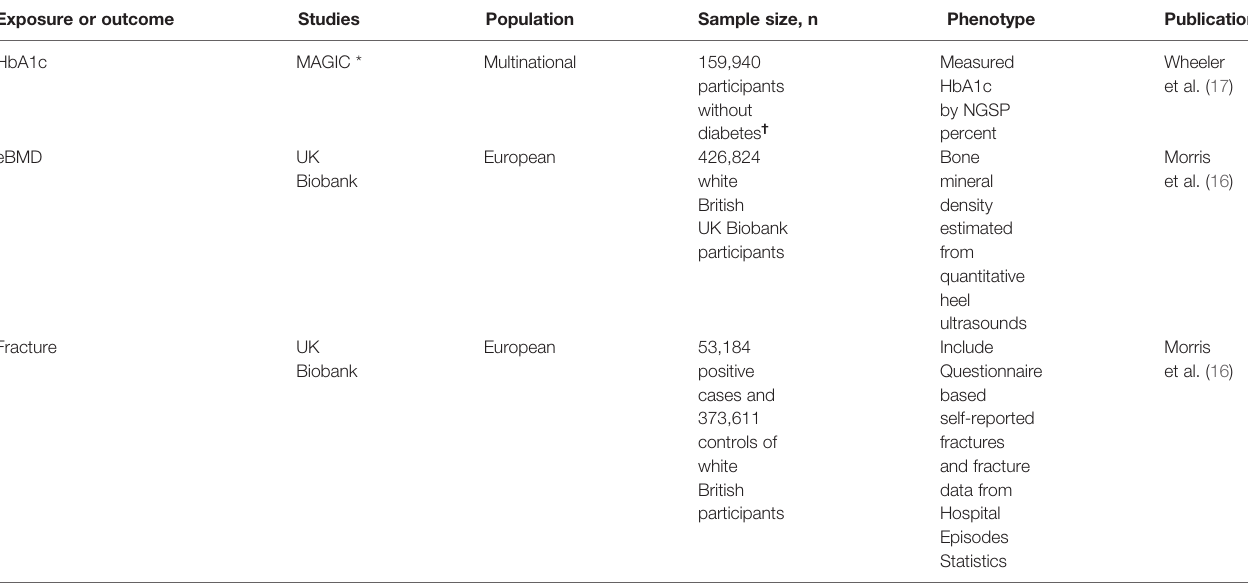
TABLE 1 | Data sets of GWAS used in the MR analysis to estimate the causal effect of HbA1c on eBMD and Fracture. Exposure or outcome